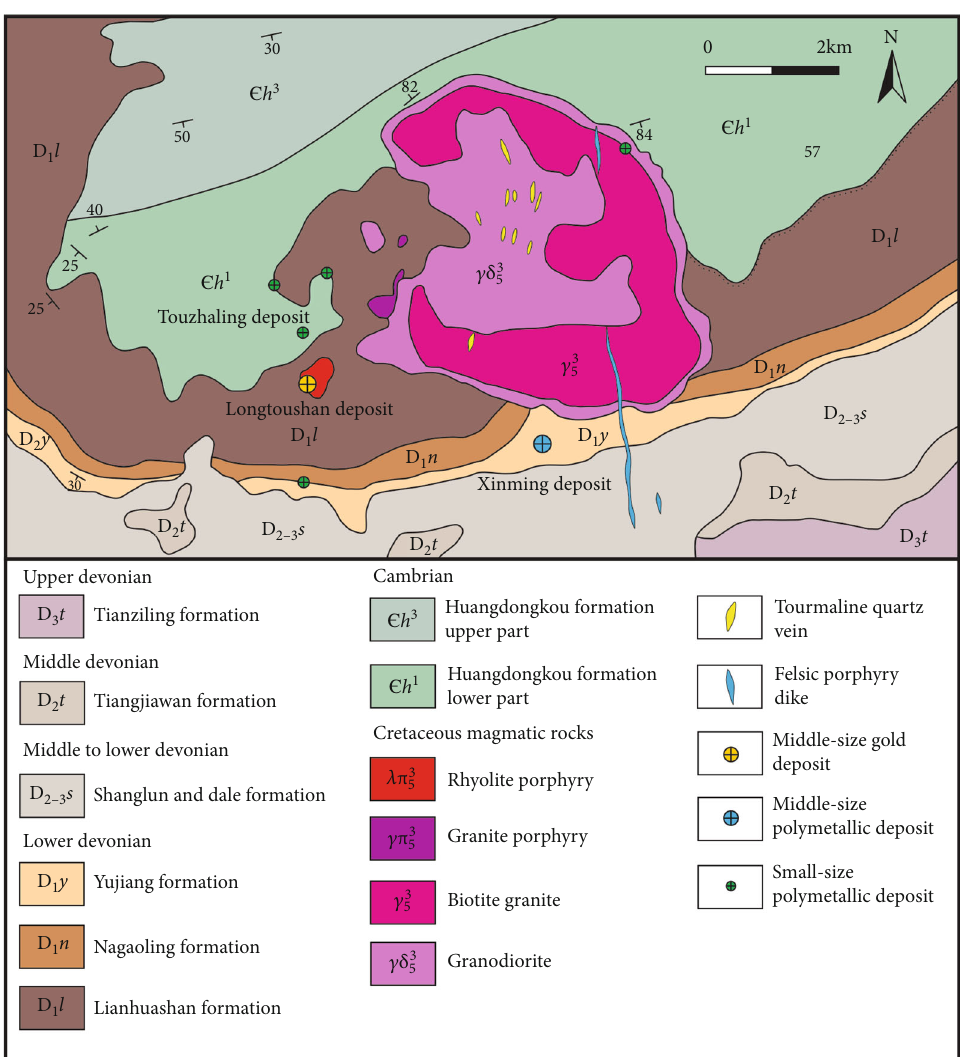
Figure 2: Simpli fi ed geological map of the Xinmin area showing the location of the Xinmin and other deposits (modi fi ed from